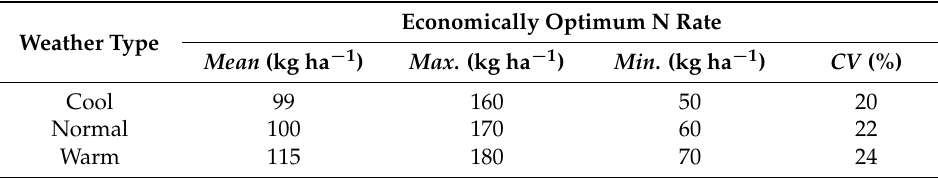
Table 4. Summary of simulated, economically-optimum N rates that maximized marginal net return under three weather types across all varieties during 1960–2014.